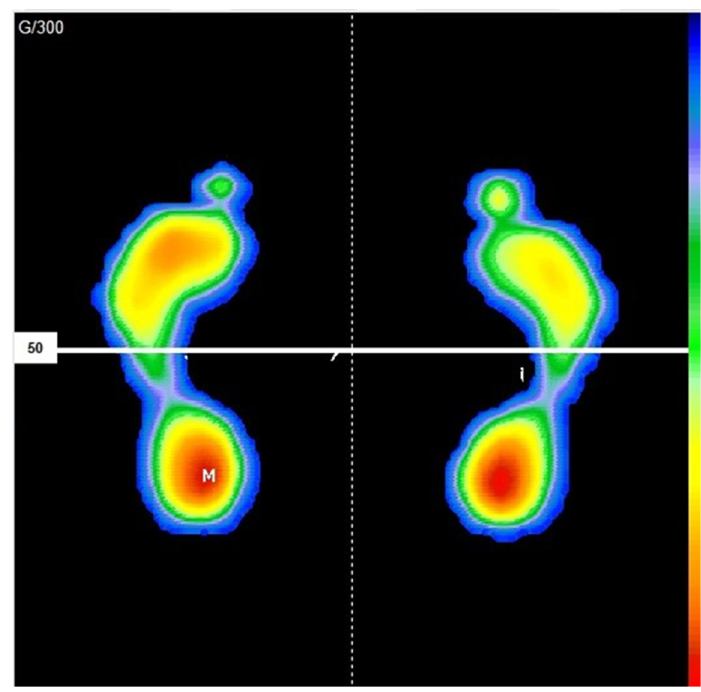
Figure 1. Static analysis of plantar pressures using S-Plate